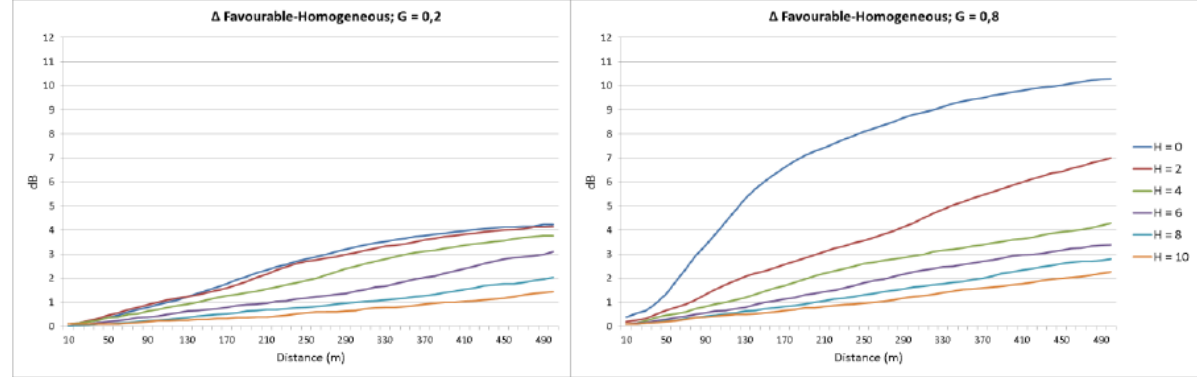
Figure 7: Differences between favourable and homogeneous conditions calculated noise levels. Ground Factor = 0, 2